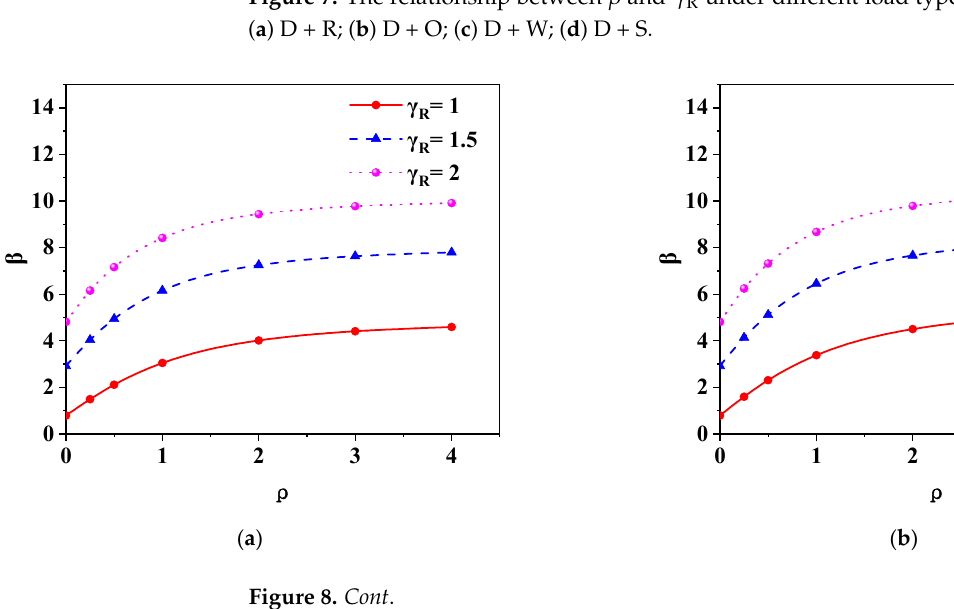
Figure 7. The relationship between β and γ R under different load types and load ratios (grade Ⅱ ): ( a )